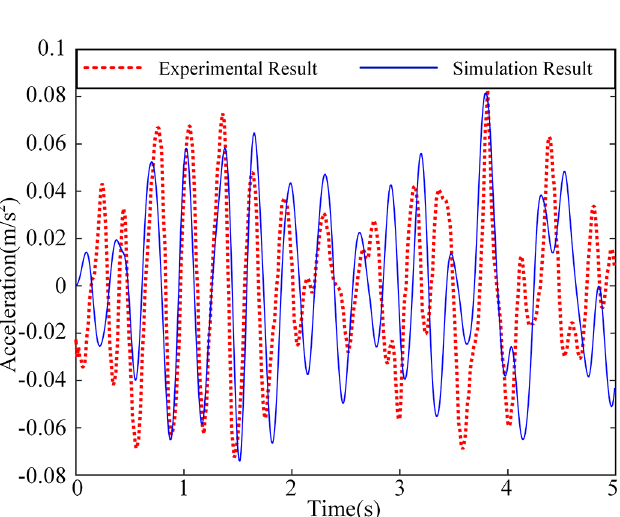
Fig. 9. Guide rail excitation.